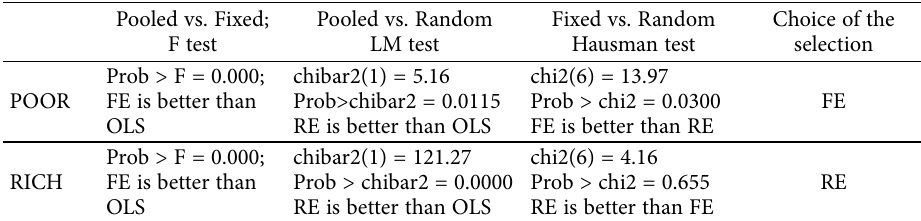
Table 2. Selection of proper model specification (rich and poor) Pooled vs. Fixed; F